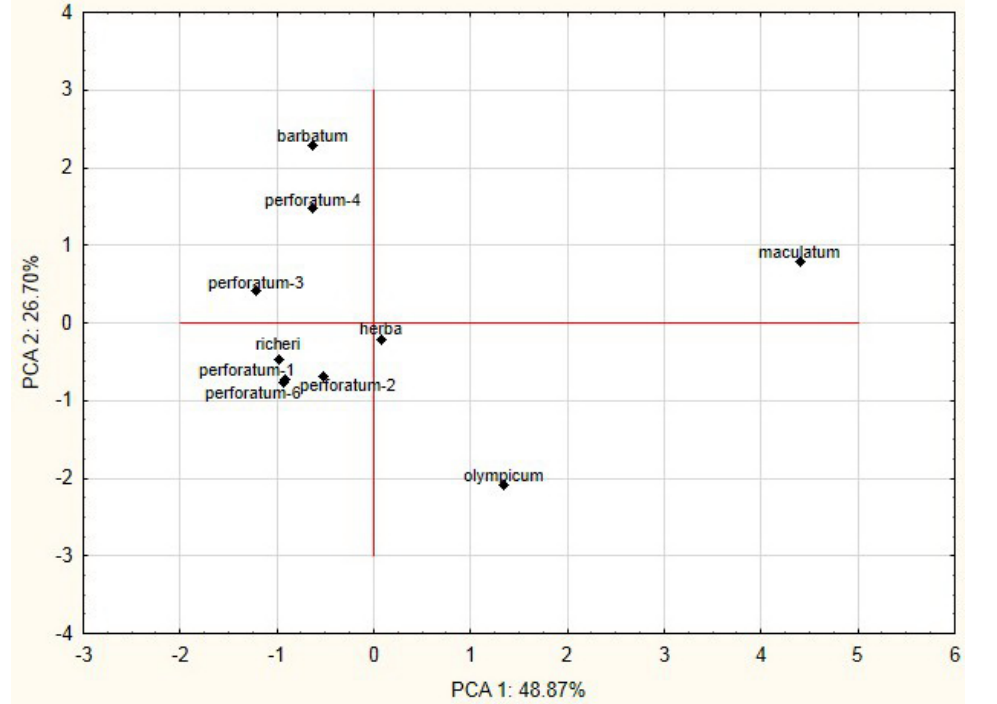
Figure 2. PCA based on compounds of investigated Hypericum species detected by HPLC